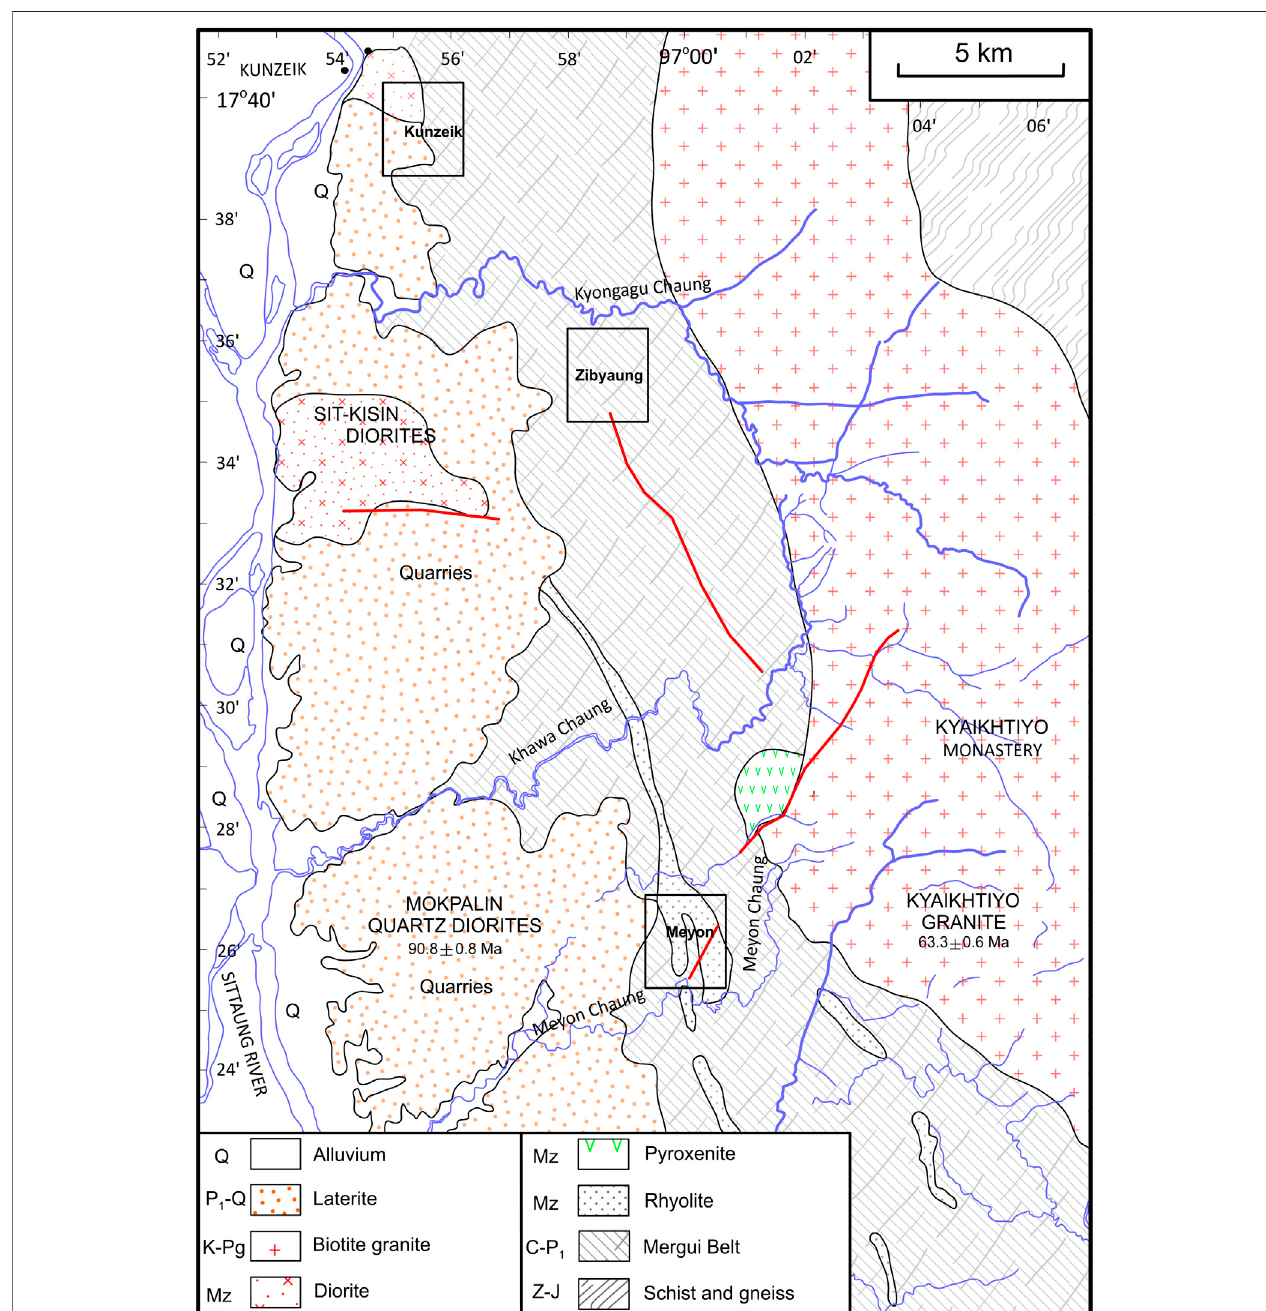
FIGURE 7 | Geological map of the Kyaikhto gold district. Red lines are faults (Modi fi ed after Mackenzie et al., 1999; Mitchell et al., 2012; Myo Kyaw Hlaing et al., 2019). Abbreviations: Q (cid:1) Quaternary, P 1 -Q (cid:1) Lower Pliocene to Quaternary, K-Pg (cid:1) Cretaceous to Paleogene, Mz (cid:1) Mesozoic, C-P 1 (cid:1) Upper Carboniferous to Lower Permian, ZJ (cid:1) Late Proterozoic to partly